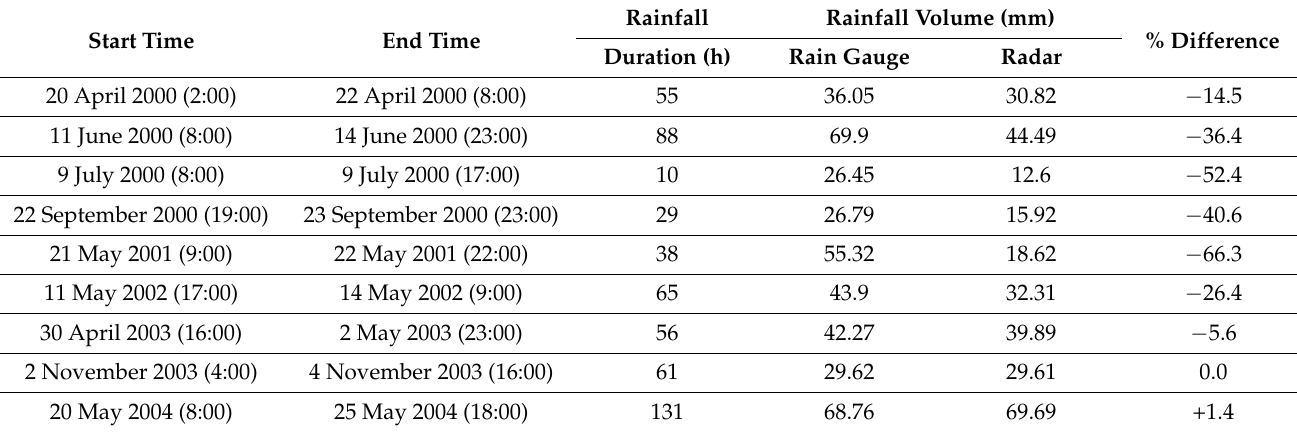
Table 1. Summary of rainfall characteristics for the nine rainfall events used in this